Question: Based on the figure, does the quantity rise or fall?
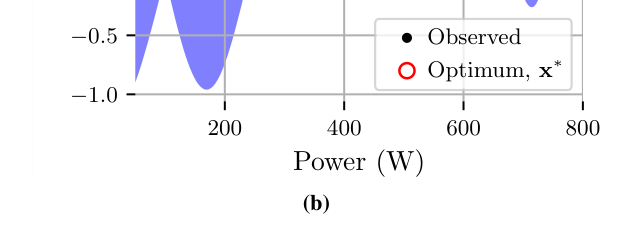
Answer: increasing